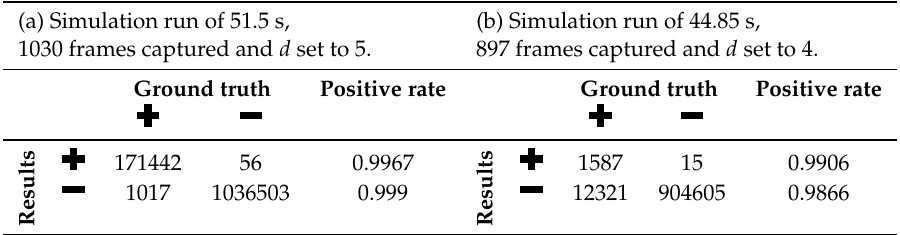
Table 2. Results from two simulation runs, changing the algorithms parameter d